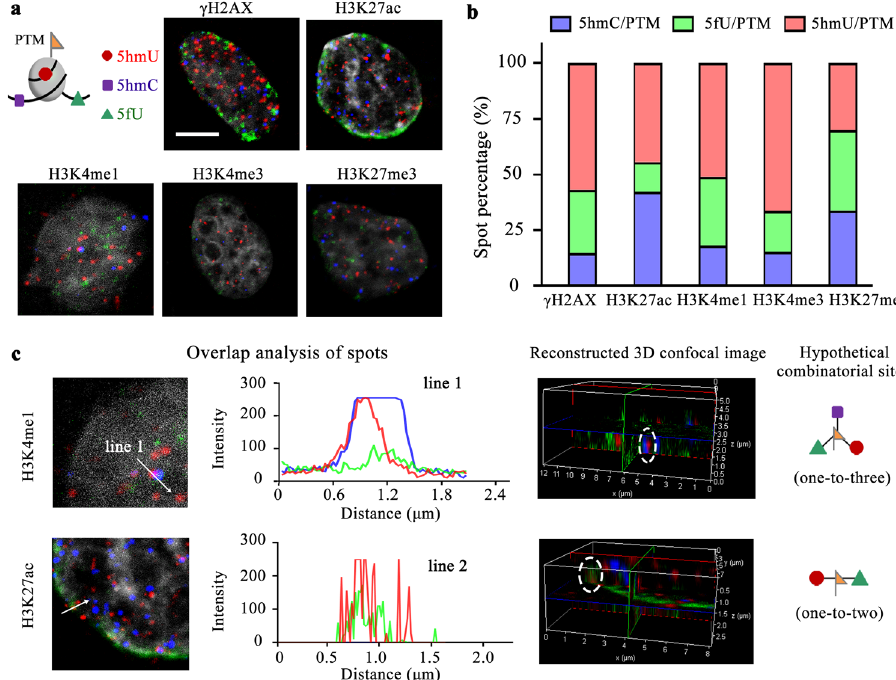
Fig. 4 Exploring different nanoenvironments of chromatin modi fi cations in single cells. a Selected merged cell images for fi ve histone PTMs. The red, green, and blue fl uorescence spots each indicated the combination sites of 5hmU/PTM, 5fU/PTM, and 5hmC/PTM. The scale bar is 5 μ m. b The spot percentages of three combination sites of single cells in fi ve samples (cell numbers = 52, 34, 32, 43, and 38, respectively). c Analysis of the overlap or cluster of different spots. For the experiments of cell imaging in all fi gures, fi ve times were repeated independently with similar